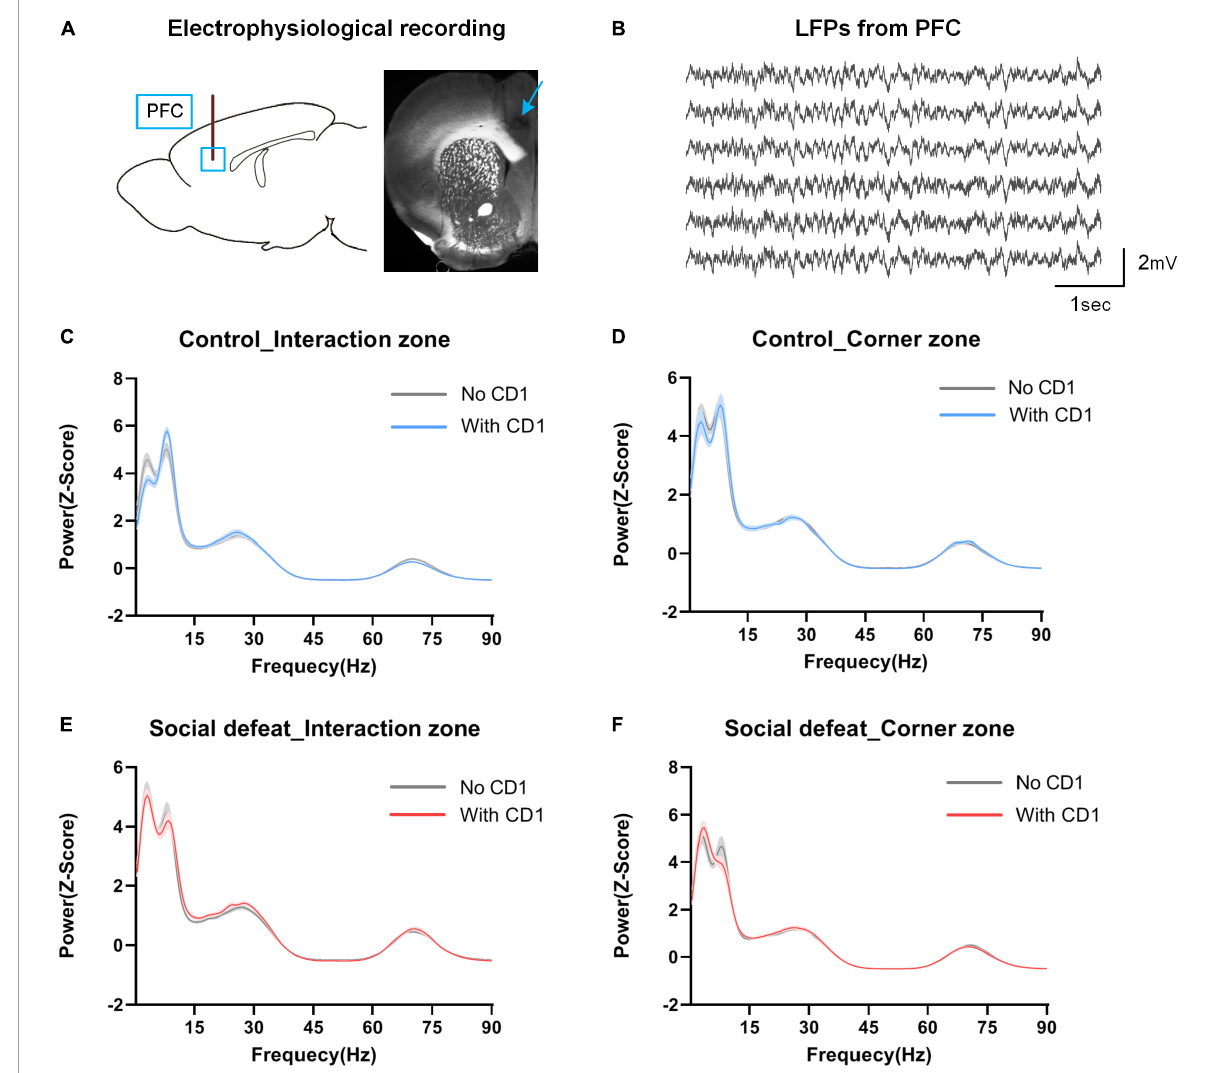
FIGURE3 Power distribution in PFC in the social interaction test. (A) Schematic of electrophysiological recording site. Blue box and arrow represent the multichannel electrodes recording site (prelimbic cortex). (B) Sample LFP traces recorded from PFC. (C,D) Spectral power in the interaction zone and corner zone for controls. (E,F) Spectral power in the interaction zone and corner zone for the socially defeated mice. Data are shown as mean ± SEM. Note the oscillatory signals within the 2–12 Hz range were highly redundant in both “With CD1” and “No CD1” phases in the interaction zone and corner zone, and the distribution shows a bimodal